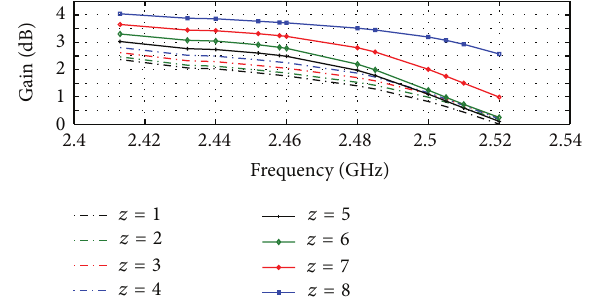
Figure 2: Effect of ground circular slot on the gain.